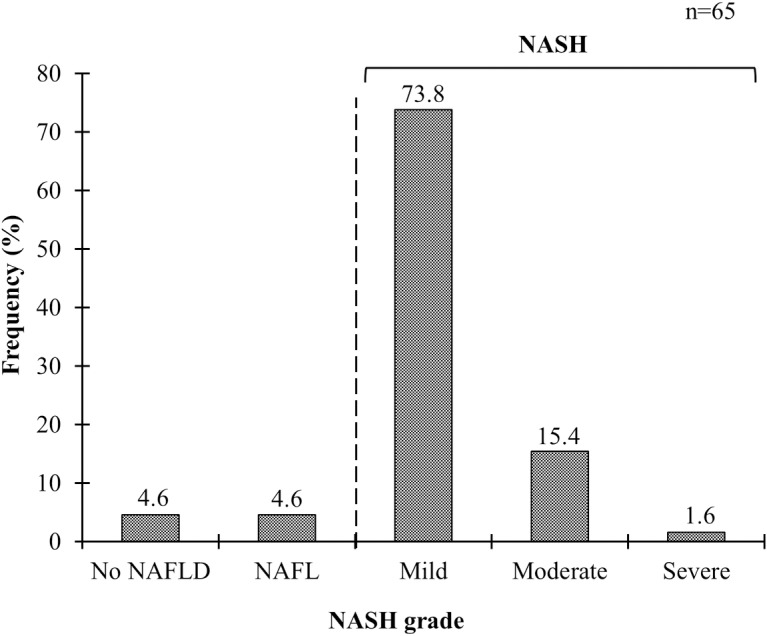
Grading of NASH according to histopathological findings.NAFLD, nonalcoholic fatty liver disease; NAFL: nonalcoholic fatty liver; NASH, nonalcoholic steatohepatitis.